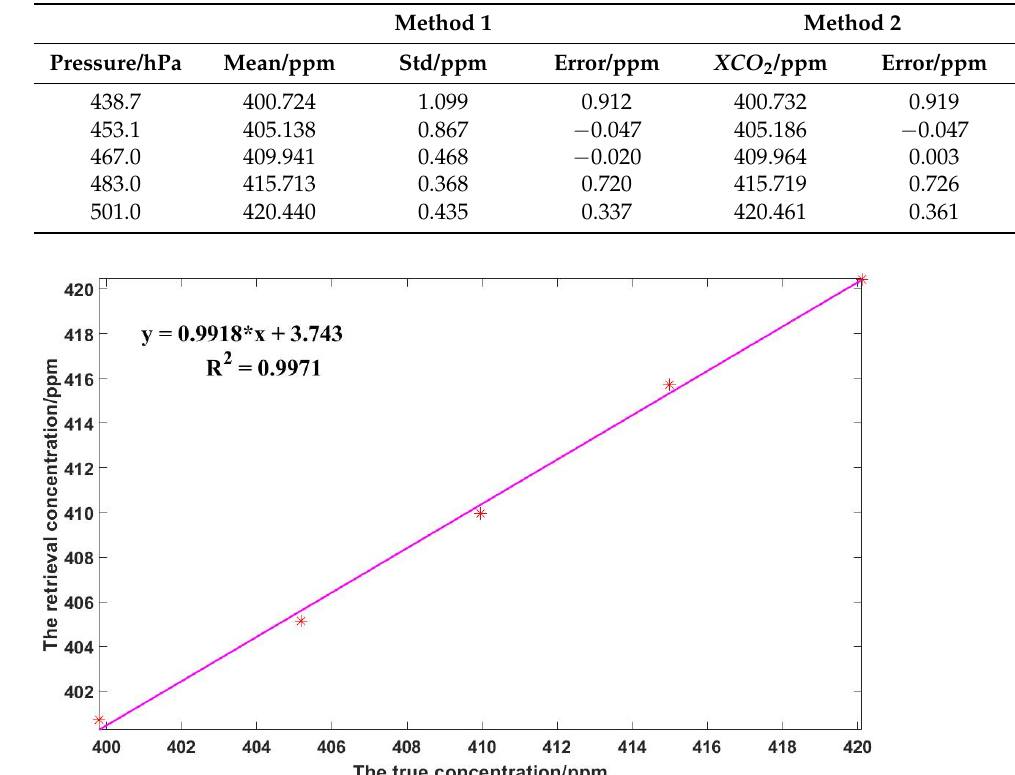
Figure 14. Linear fit of true and retrieval concentrations. The red * indicates the retrieval concentration corresponding to each true concentration. Table 8. Comparison of retrieval results.